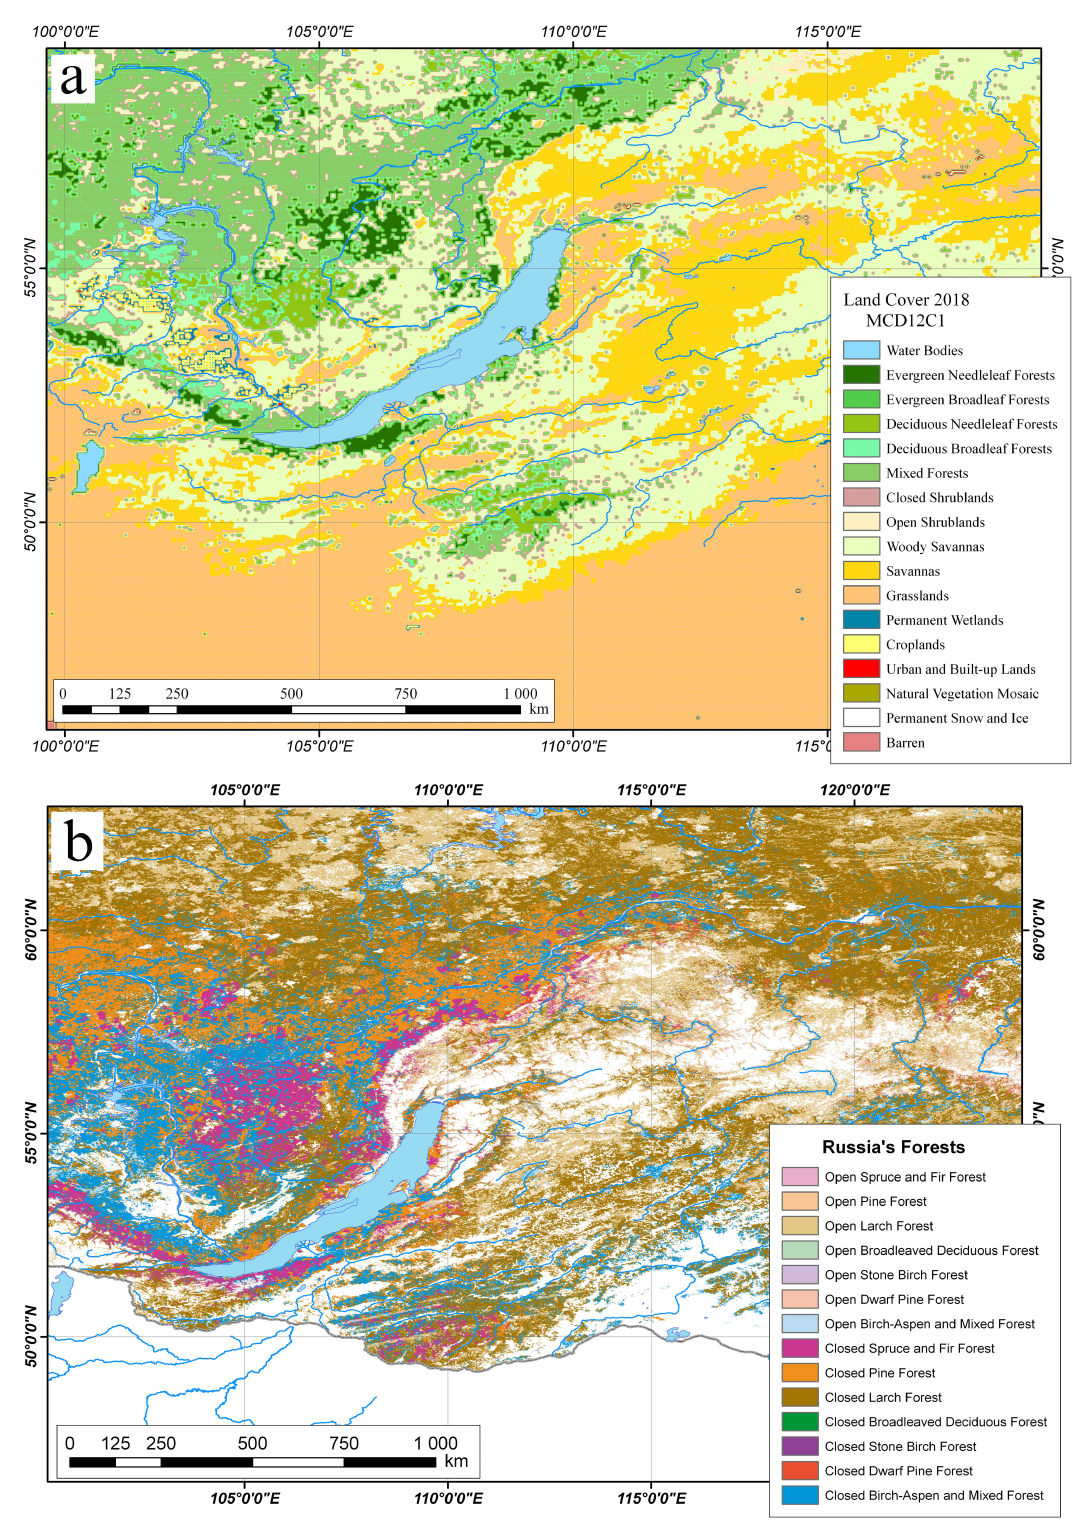
Figure 2. ( a ) MCD12C1 land-cover map nearby Lake Baikal in 2018. The spatial resolution of the map is 0.05 ◦ . The vegetation legends correspond to the International Geosphere-Biosphere Program (IGBP) classes. ( b ) The Russian Forest map in